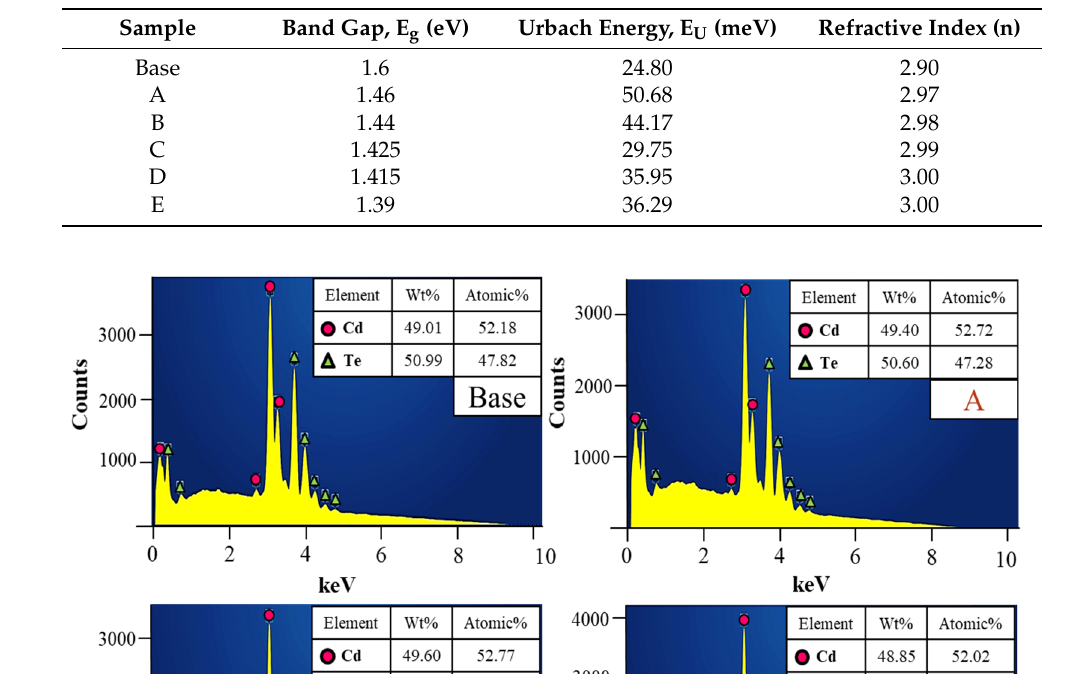
Table 4. Optical parameters of CdTe thin film for various annealing temperatures.